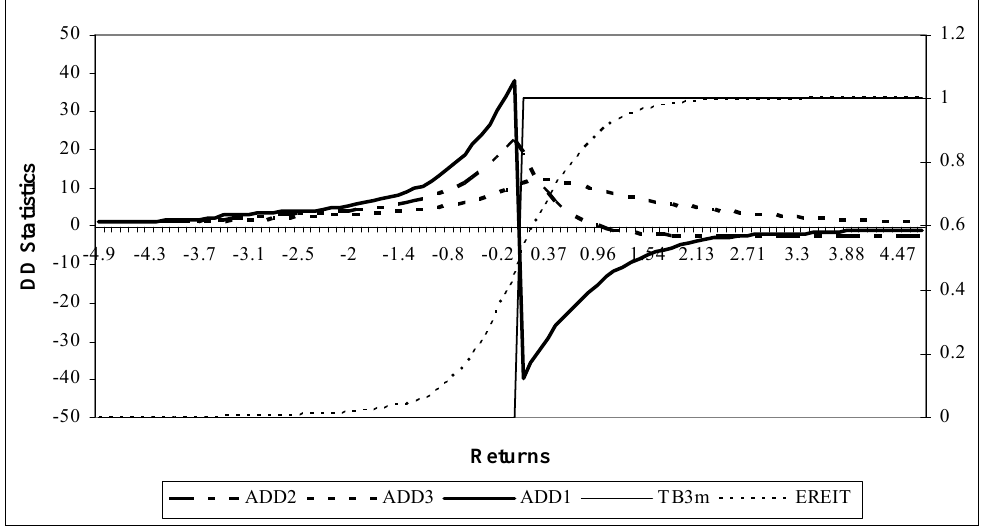
Figure 2: CDF and DD Statistics Between Equity REITs and 3-Month T. Bill for